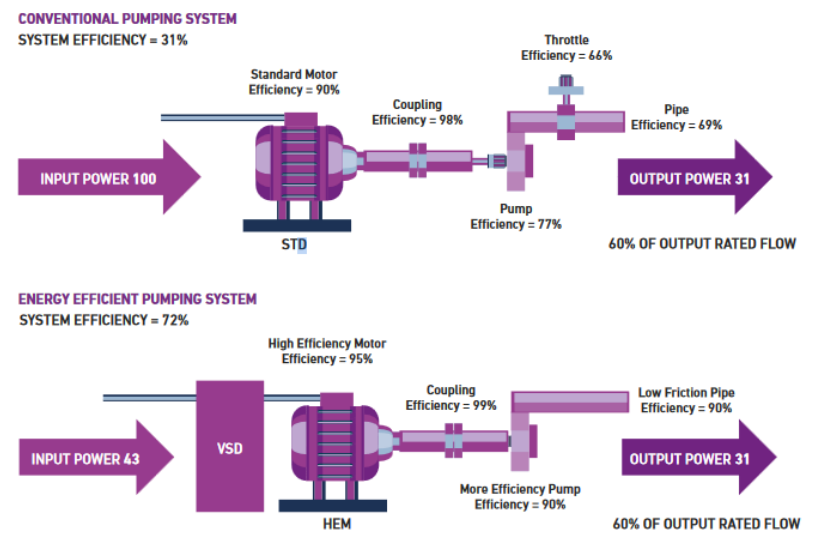
Figure 8. Efficiency of a pumping electric motor system, showing the energy saving potential [27].